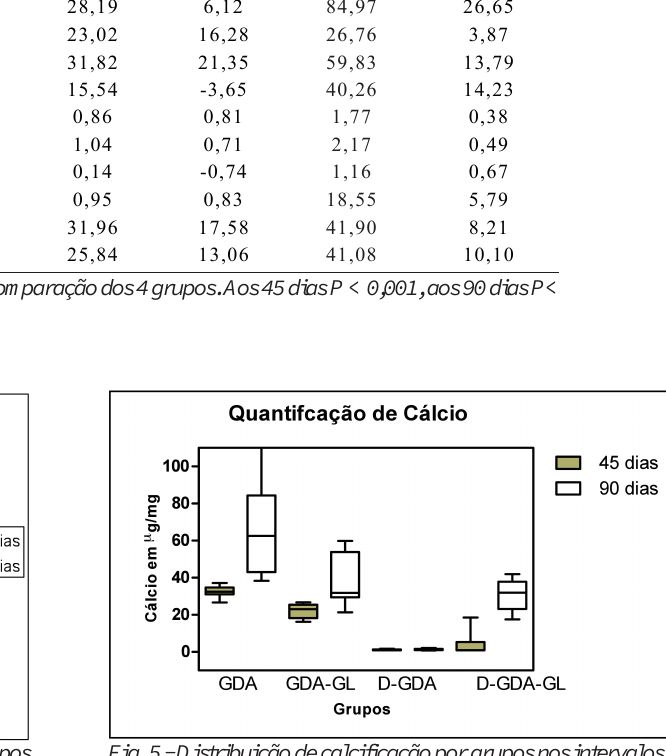
estudados nos diferentes pHs, com 45 e 90 dias de evolução